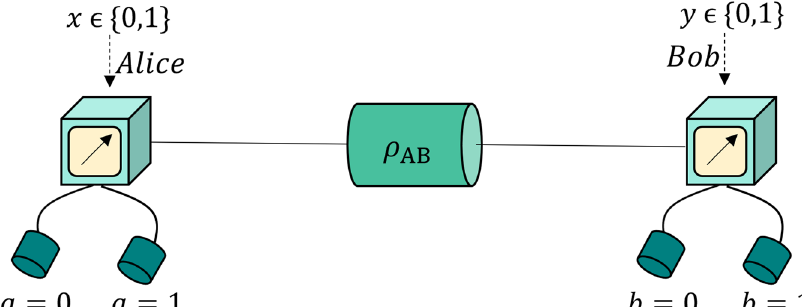
Fig. 1 CHSH test setup. A central source distributes quantum states ρ AB to Alice and Bob, who interact with their measurement devices by providing binary inputs ( x and y ) and recording binary outputs ( a and b ) to estimate their CHSH winning probability, ω . As an example, the Tsirelson ’ s bound ω ¼ ð 2 þ the measurement of the observables A x and B y , where A 0 = σ Z , A 1 = σ X , B 0 ¼ ð σ Z þ σ X Þ = matrices). In this ideal example, Alice records output a upon observation of the eigenvalue ( − 1) a , and similarly for